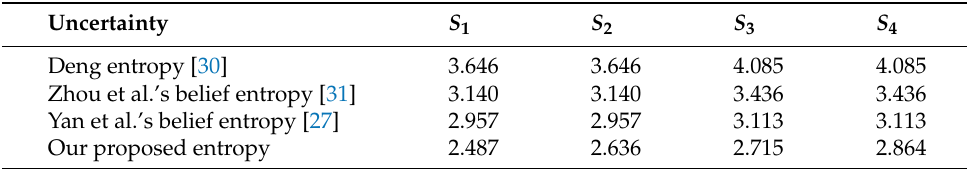
Table 3. Uncertainty measure of Example 2 with four